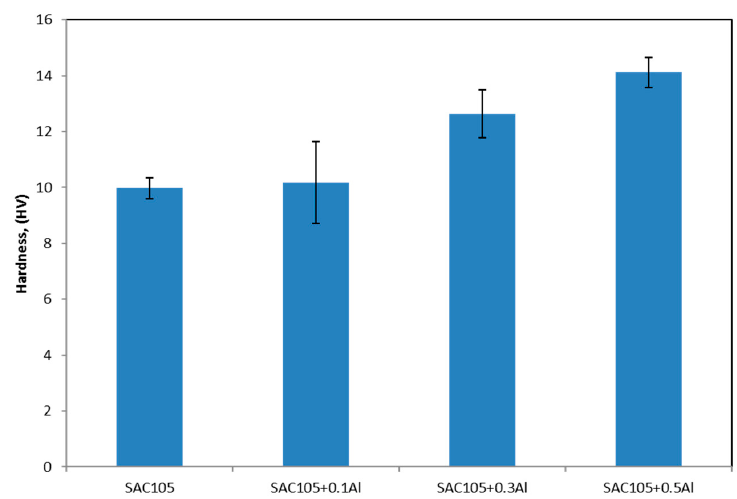
Figure 11. Variation of Vickers hardness with Al content for as received samples.